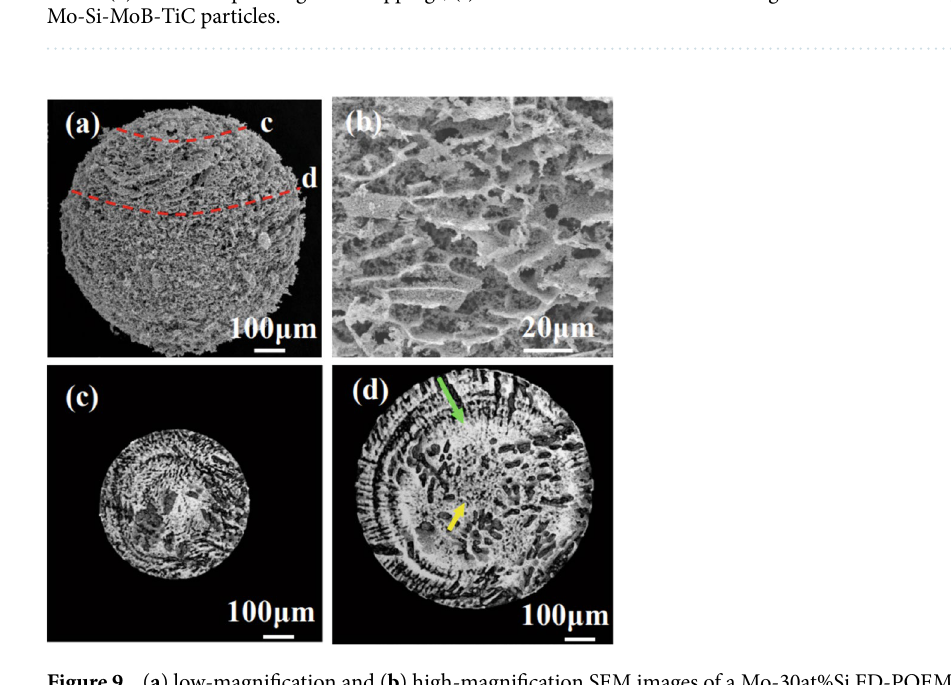
Figure 9. ( a ) low-magnification and ( b ) high-magnification SEM images of a Mo-30at%Si FD-POEM particle. ( c , d ) The X-ray CT images of the areas marked by red lines in ( a